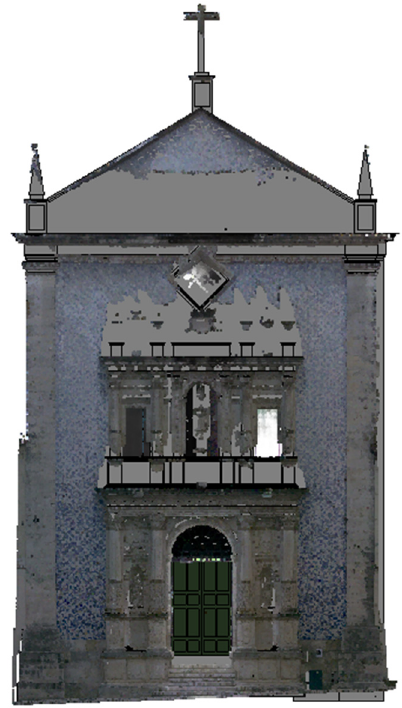
Figure 4. Point cloud on the 3D model in Revit.